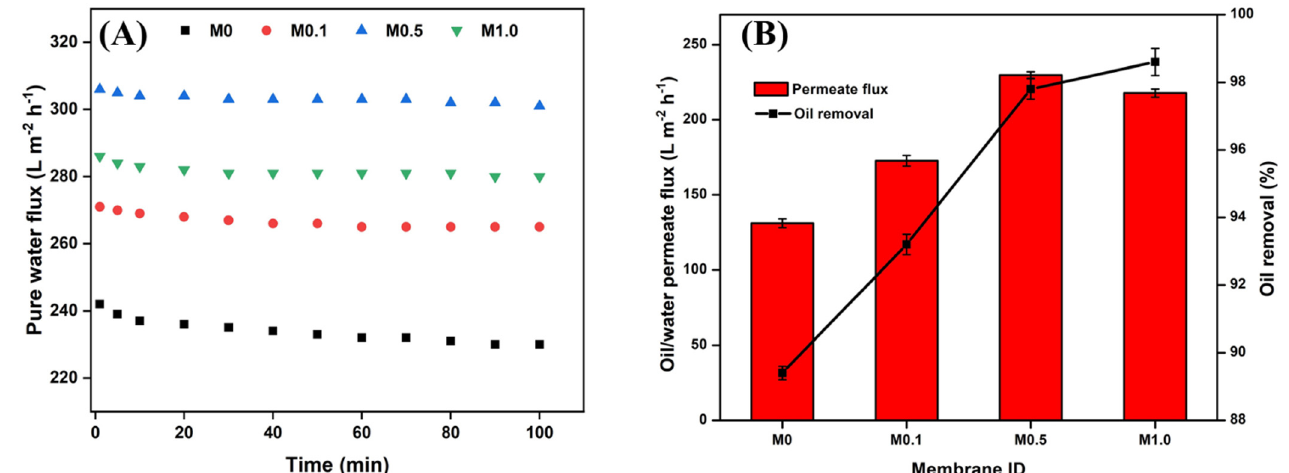
Figure 7. ( A ) Pure water fluxes and ( B ) o/w separation performance of pristine and coated mem- branes .